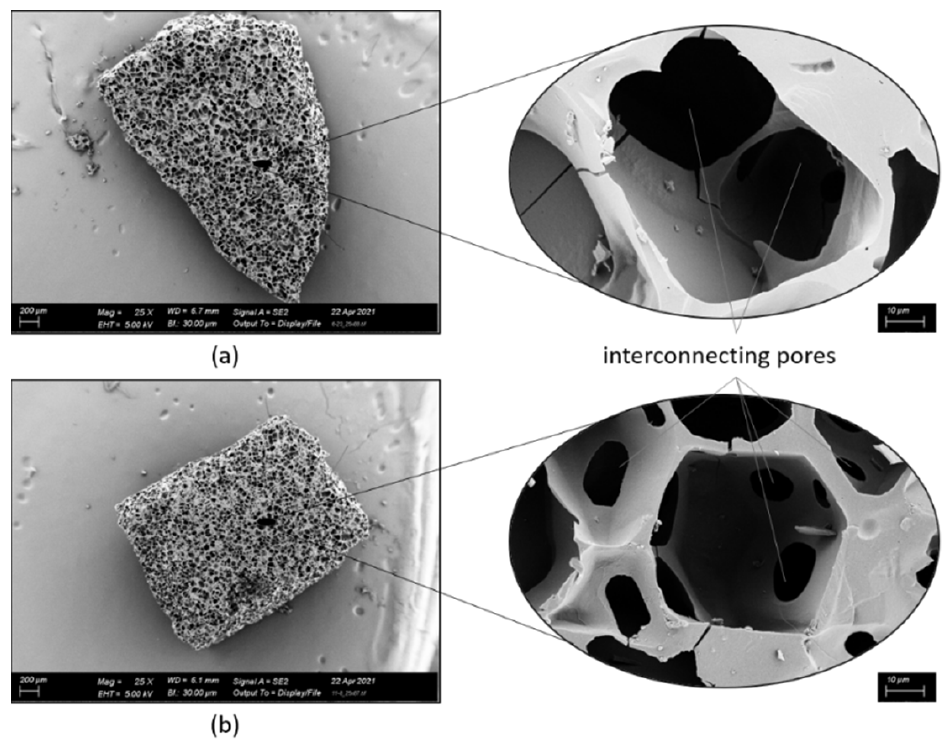
Figure 5. Scanning electron microscopy (SEM) pictures of selected samples, showing the difference in size of interconnecting pores: ( a ) sample 23, magnification 25 × and 1000 × , respectively, ( b ) sample 8, magnification 25 × and 1000 × , respectively.